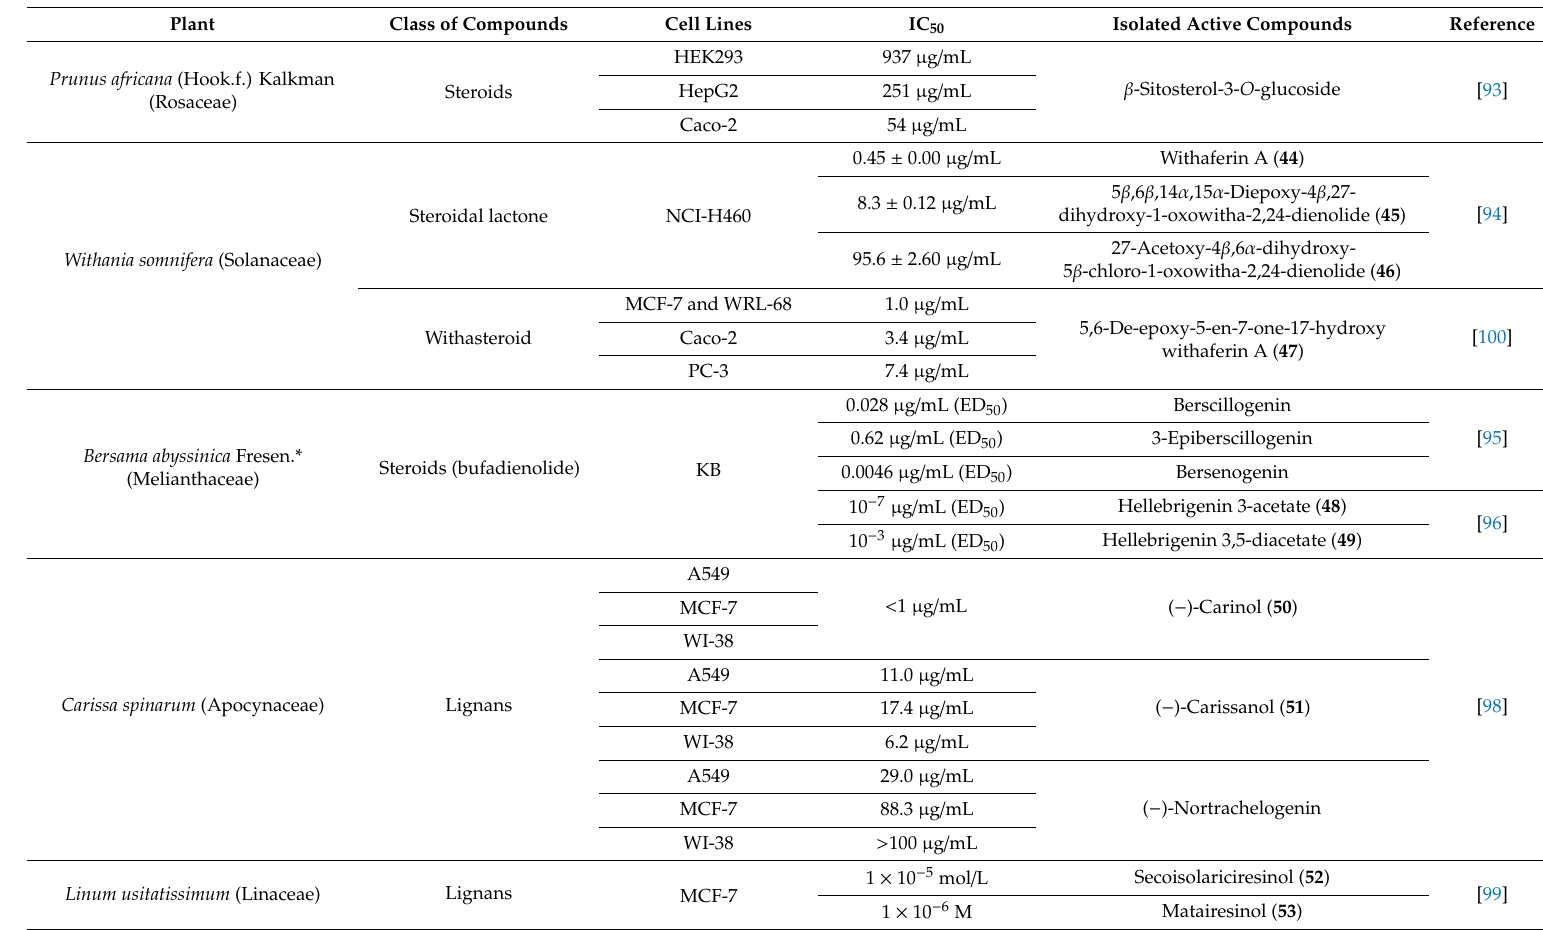
Cell lines: HEK293 = Human embryonic kidney, HepG2 = Liver hepatocarcinoma, Caco-2 = Human colon carcinoma, NCI-H460 = Human large-cell lung carcinoma, MCF-7 = Human breast adenocarcinoma, WRL-68 = human hepatic, PC-3 = Human prostate cancer, KB = Human mouth epidermal carcinoma, MGC-803 = Human gastric cancer, A-549 = Human lung adenocarcinoma, WI-38 = Normal human embryonic, IC 50 = Concentration that inhibited cell proliferation by 50%. ED 50 = E ff ective dose for 50% of the population * Plant material collected from